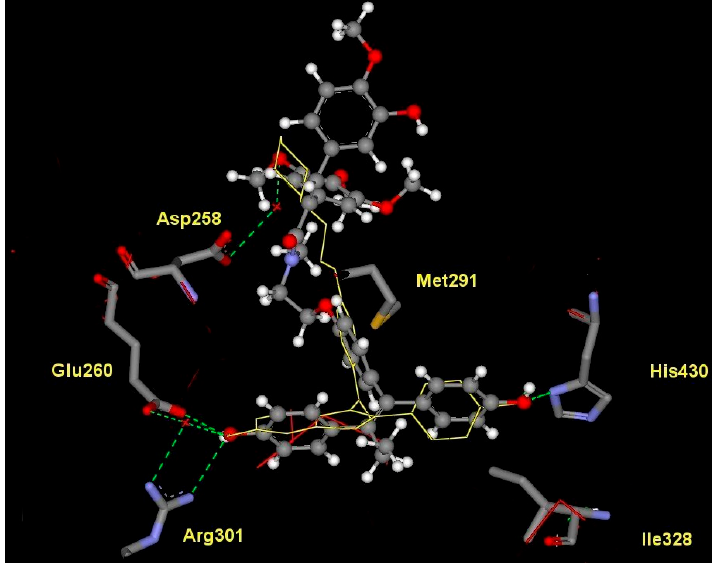
Figure 4. Predicted binding mode of compound 28 in the ligand binding domain of ER β . Highest-ranking docking orientation and predicted receptor interactions for 28 (ball-and-stick representation) in ER β compared to the crystal solution for 4-hydroxytamoxifen (yellow) (pdb 1QKN) [42]. (H-bond interactions are illustrated as broken lines).